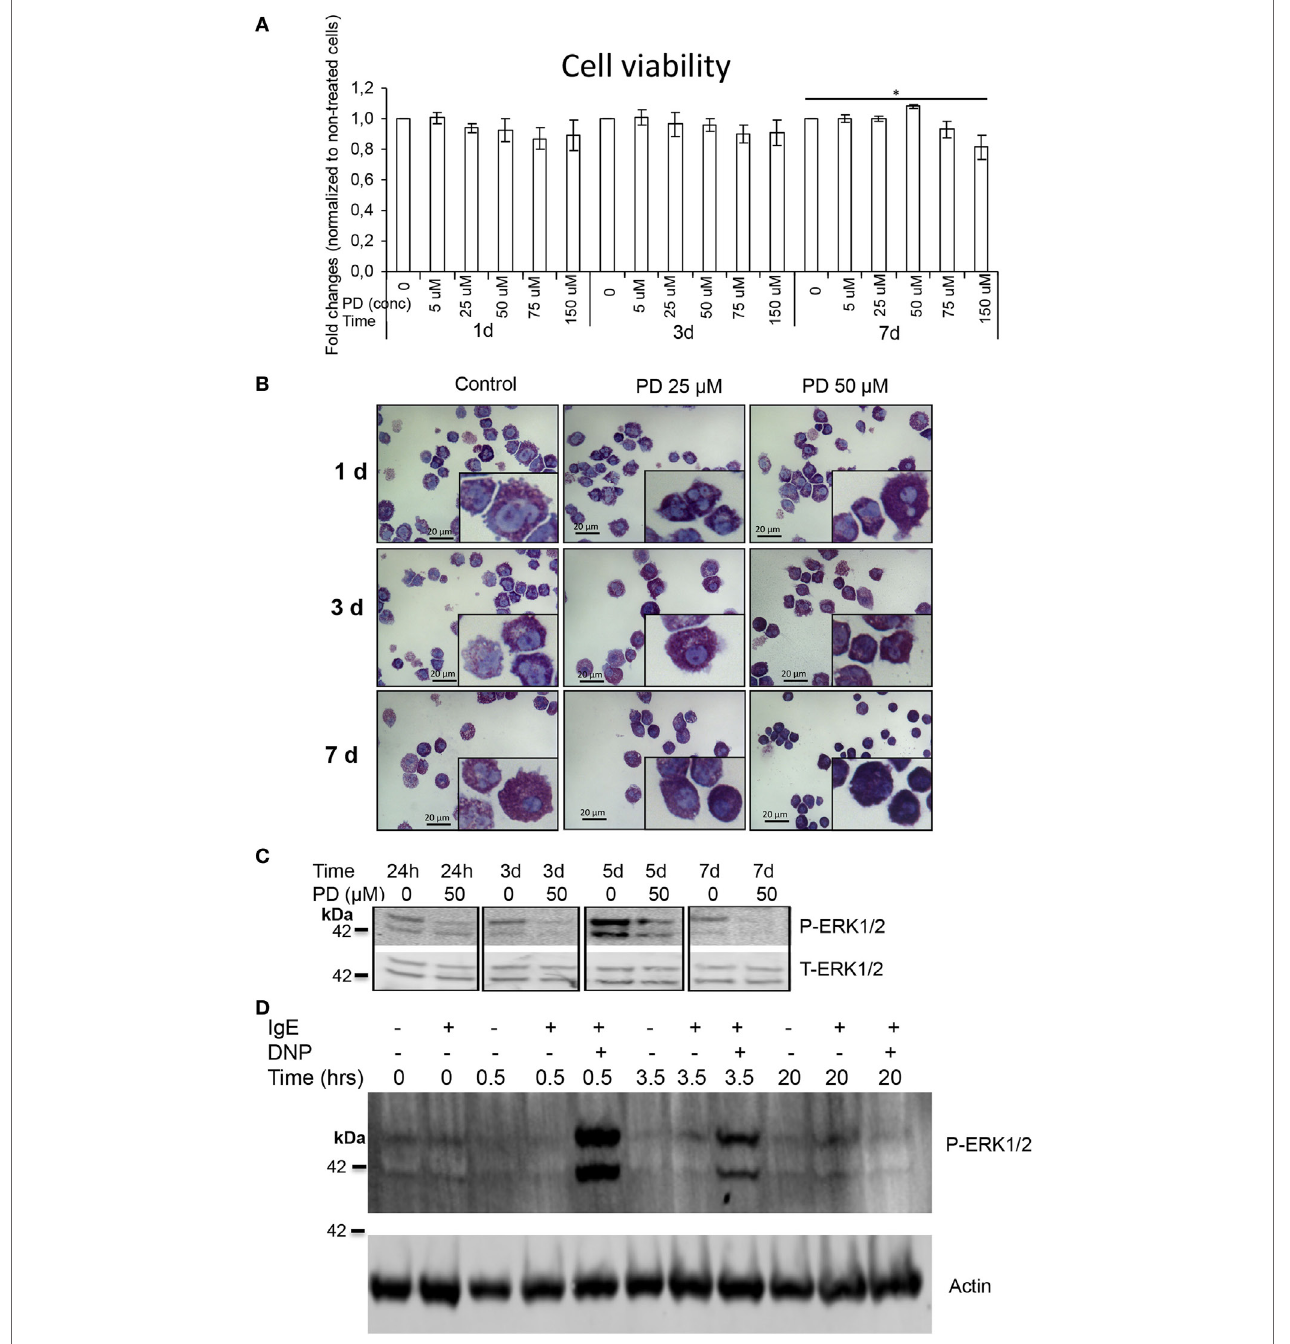
FigUre 1 | MEK1/2 inhibition induces granule maturation in mast cells (MCs). Bone marrow-derived mast cells (0.5–1.0 × 10 6 cells/ml) were incubated with PD98059 (PD) at the concentrations and time periods indicated. (a) The viability of MCs after incubation with PD98059 was assessed using a CellTiter-Blue Cell Viablity Assay ( n = 3). (B) After incubation with PD98059, cytospin slides were prepared and stained with May-Grünwald/Giemsa. The insets represent enlarged images of MCs with representative morphology. Note that treatment with PD98059 causes increased May-Grünwald/Giemsa staining intensity of granules. Original magnification: 40 × . (c) Western blot analysis showing that the MEK1/2 inhibitor (PD98059; PD) causes reduced phosphorylation of ERK1/2 (P-ERK1/2), without affecting the total ERK1/2 levels (T-ERK1/2). (D) Western blot analysis of ERK1/2 phosphorylation after IgE receptor crosslinking. MCs (1 × 10 6 cells) were incubated overnight either alone or with IgE anti-DNP (IgE) as indicated. Cells were then washed followed by the addition of DNP-HSA (DNP) to induce IgE receptor crosslinking as indicated. At the time points indicated, cells were recovered and analyzed for phosphorylated ERK1/2 (P-ERK1/2). Actin was used as loading